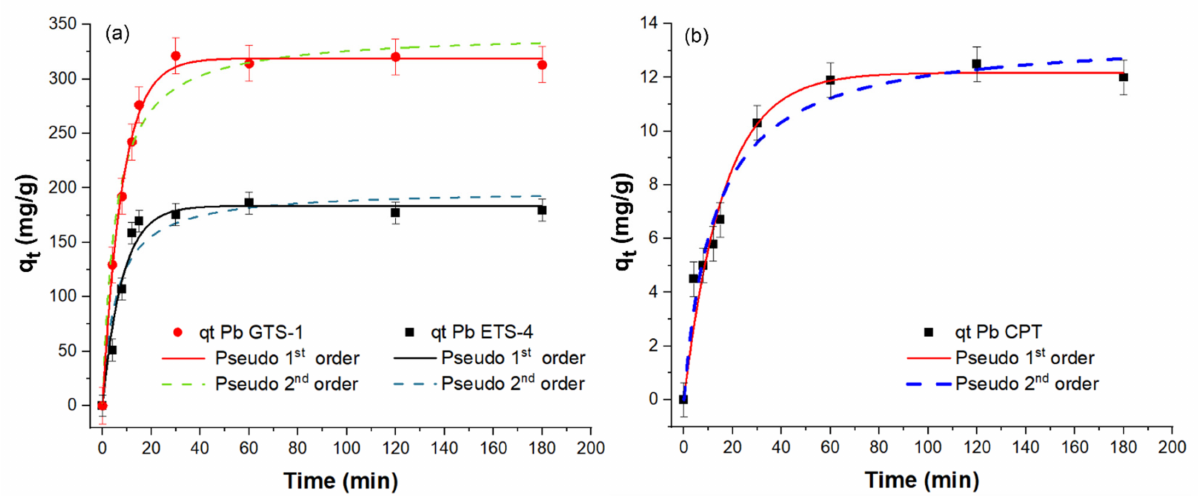
Figure 7. Pb 2+ adsorption kinetics of ( a ) H-ETS-4 and H-GTS-1, and ( b ) H-CPT. The kinetics were followed for 4, 8, 12, 15, 30, 60, 120, and 180 min using Pb 2+ aqueous solutions with concentrations of 400 mg/L for CPT and 3600 mg/L for ETS-4 and GTS-1. The best fit of the experimental data ( q t ) for H-CPT, H-ETS-4, and H-GTS-1 is given with solid